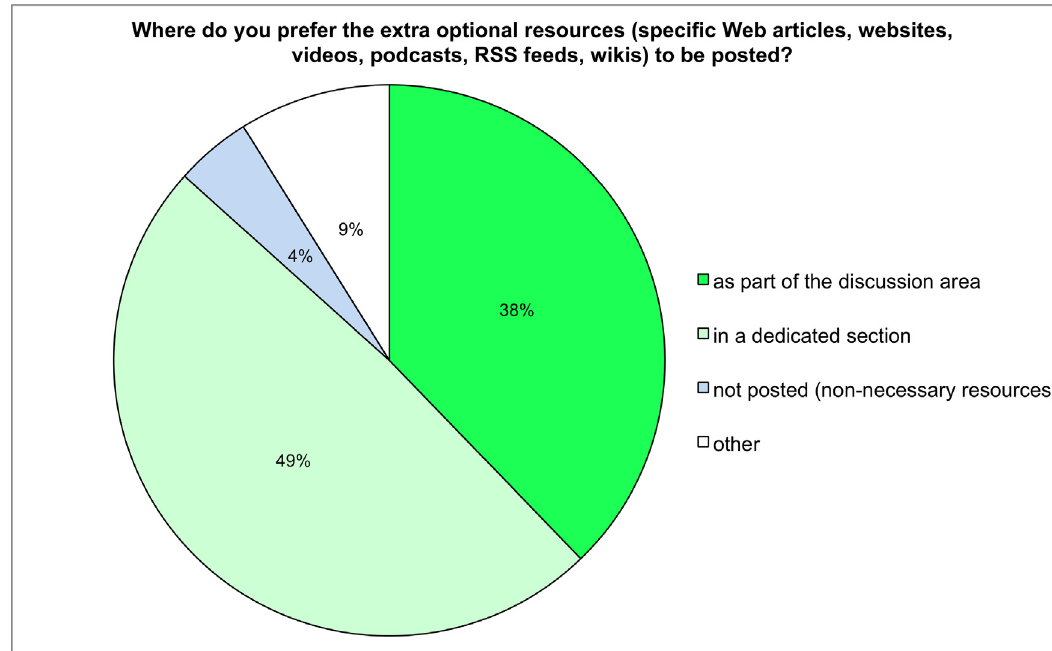
Figure 7 . Student preference for extra resource location.